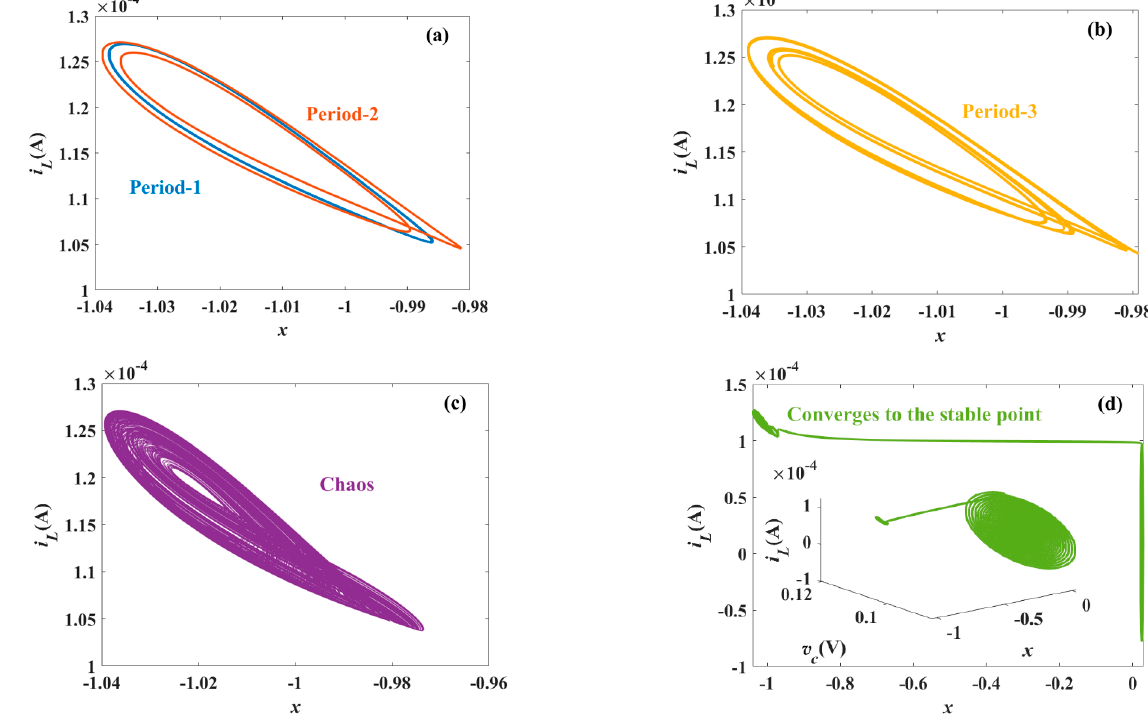
Figure 22. Variation in system attractor with inductance L, v = 0.1031 V, C = 26 μ F. ( a ) L = 0.88 H, L = 0.91 H, ( b ) L = 0.925 H, ( c ) L = 0.95 H, ( d ) L = 0.963 H.